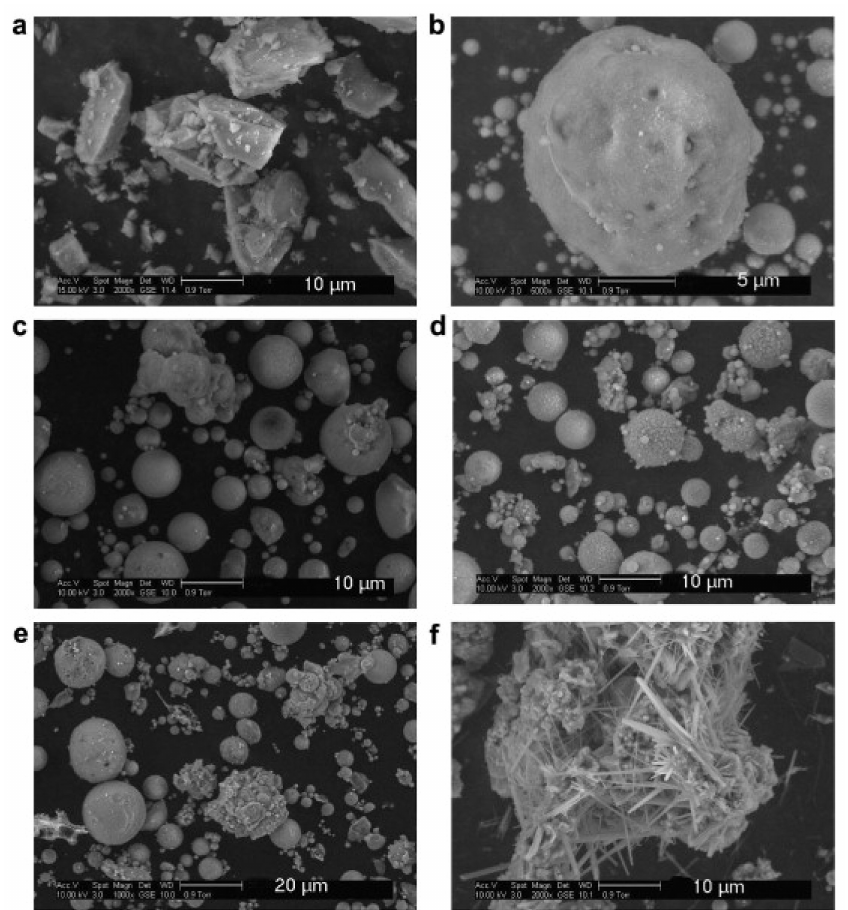
Figure 5. Scanning electron micrographs (SEMs) of cement and fly ash. ( a ) Cement; ( b ) Class C;